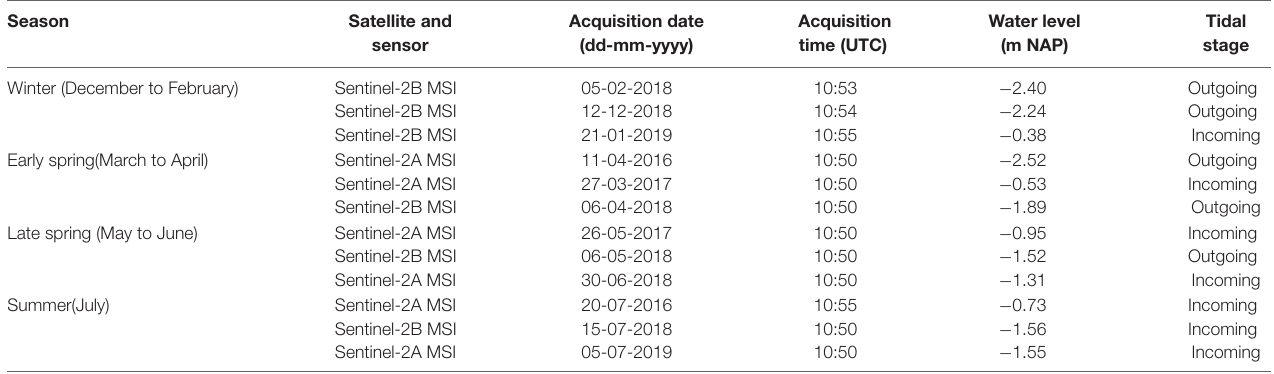
TABLE 1 | Overview of Copernicus Sentinel-2 MSI imagery used for data